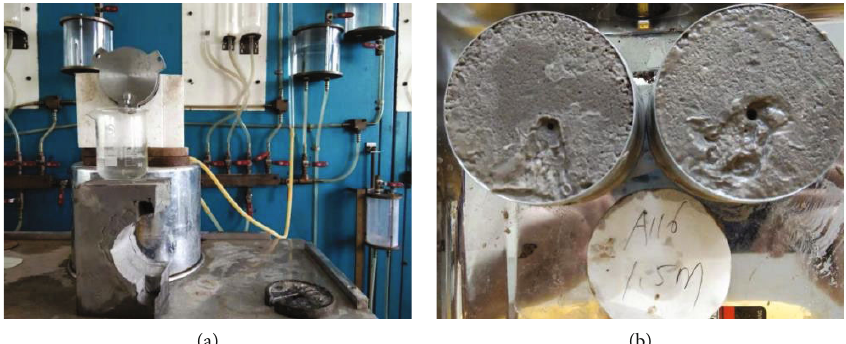
Figure 7: Pinhole experiment: (a) pinhole experimental device; (b) aperture observation of pinhole experiment.